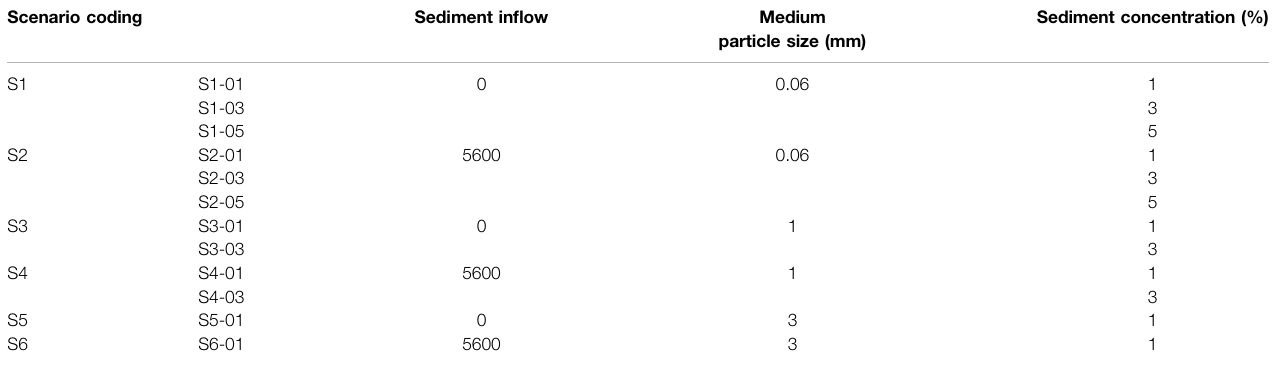
TABLE 3 | Scenario runs to assess the sensitivity of fl ooding hazard to sediment characteristics. Scenario